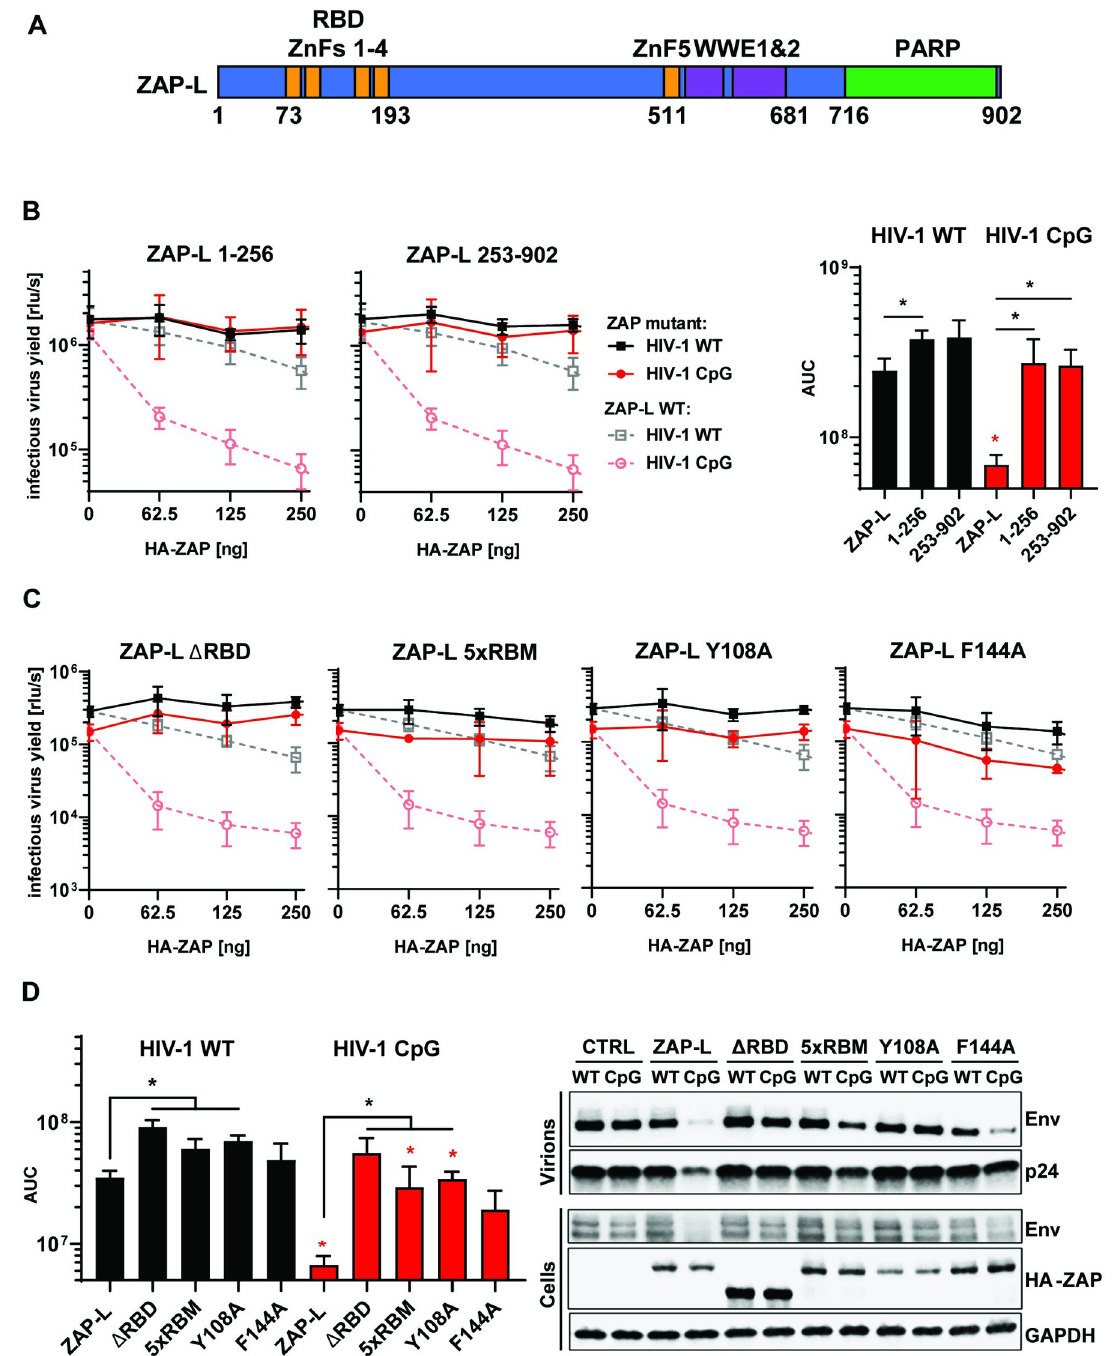
Fig 1. RNA binding is crucial for ZAP’s antiviral activity. (A) Schematic showing domain organisation of long isoform of ZAP (ZAP-L): four N-terminal zinc fingers form RNA binding domain (RBD), fifth zinc finger (ZnF5) and two WWE domains are located in the central part and catalytically inactive Poly(ADP-ribose) polymerase (PARP) domain is at the C-terminal part. (B) Infectious virus yield measured by TZM-bl infectivity assay in relative light units per second [rlu/s] obtained from HEK293T ZAP KO cells co-transfected with wild type (WT; black) HIV-1 and CpG-enriched mutant (CpG-high; red) viruses and increasing doses of pcDNA HA-ZAP constructs encoding the full-length ZAP-L (dashed line), 1-256aa or 253-902aa parts of the protein (solid lines) (left panel). Area Under the Curve (AUC) calculated from the same titration experiments (right panel). (C) Infectious virus yield from HEK293T ZAP KO co-transfected with WT and mutant virus and increasing concentration of pcDNA HA-ZAP with truncated ZAP 253–902 ( Δ RBD), ZAP-L mutant unable to bind RNA (V72A/Y108A/F144A/H176A/R189A; 5xRBM) or ZAP-L with substitutions at positions in direct contact with bound